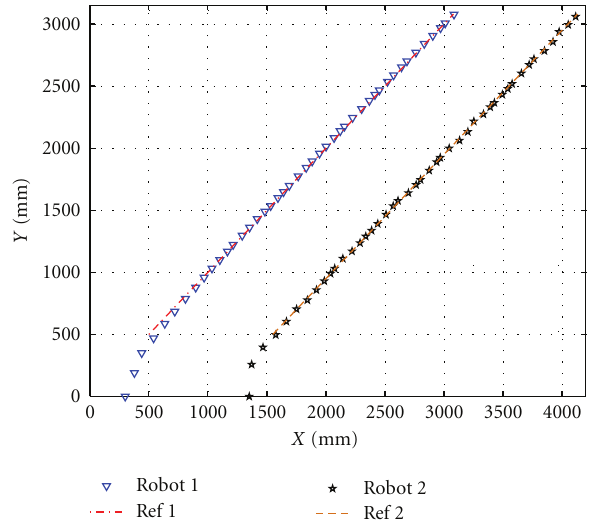
Figure 14. If the group moves for over 200 seconds, then the speed of the virtual leader along Y -axis becomes more than 0.8 meters per second which is the maximum speed of P3-AT. This is the main di ff erence compared with the previous test (straight line